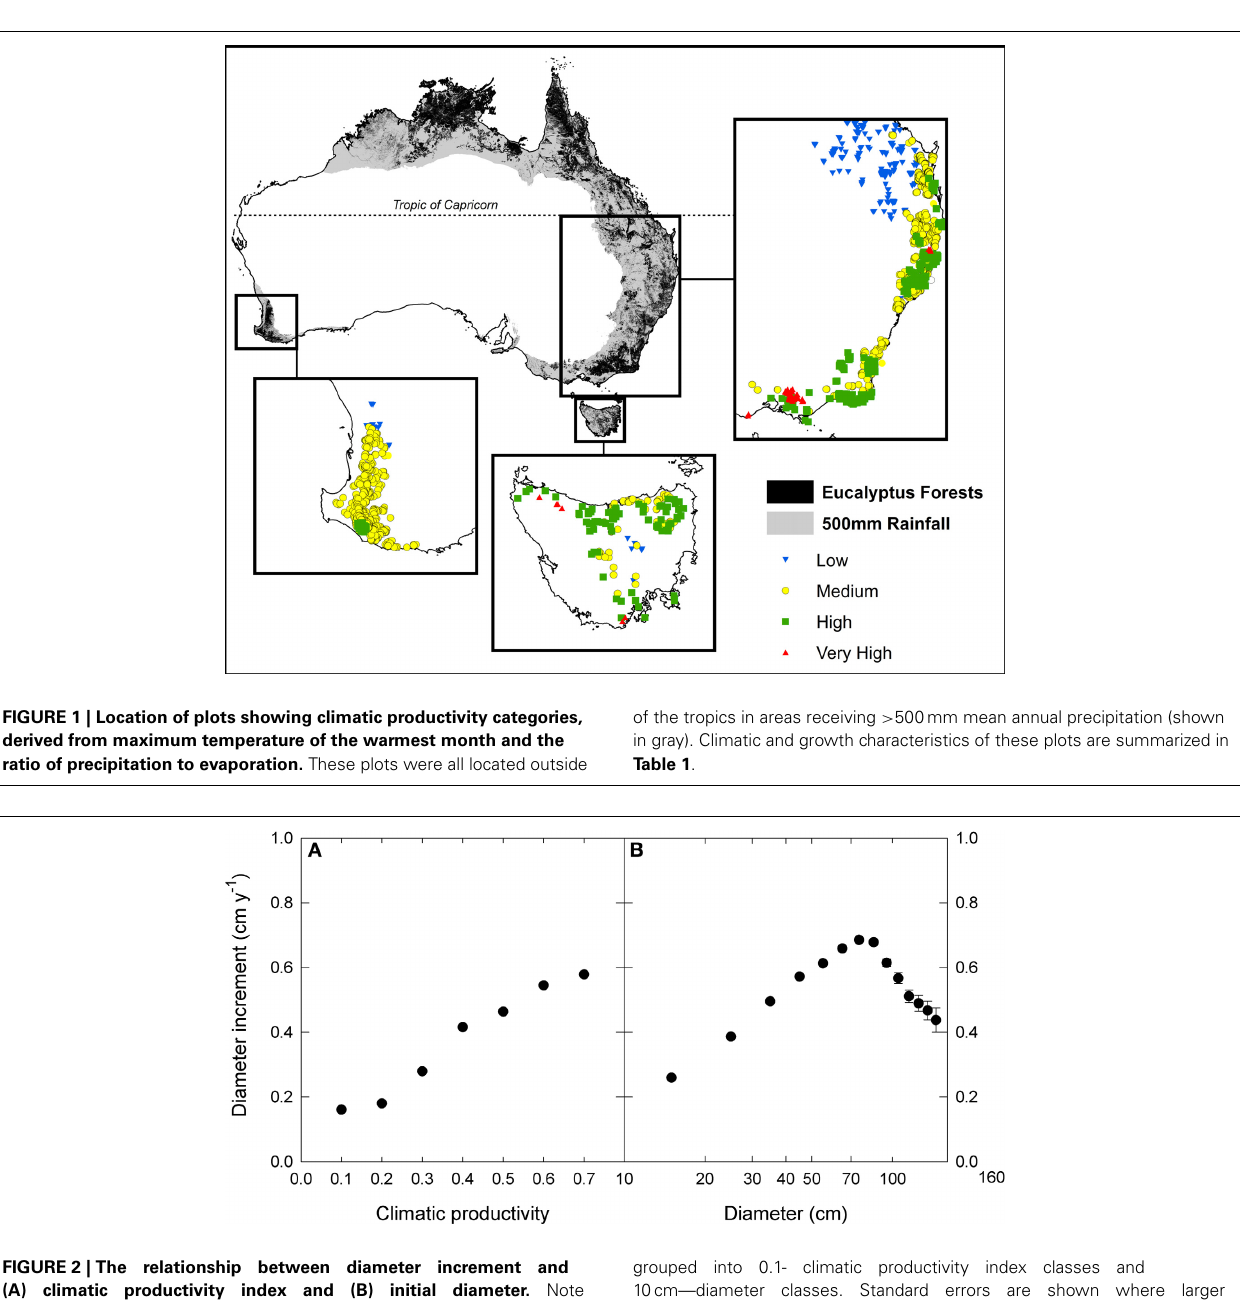
grouped into 0.1- climatic productivity index classes and 10cm—diameter classes. Standard errors are shown where larger than the